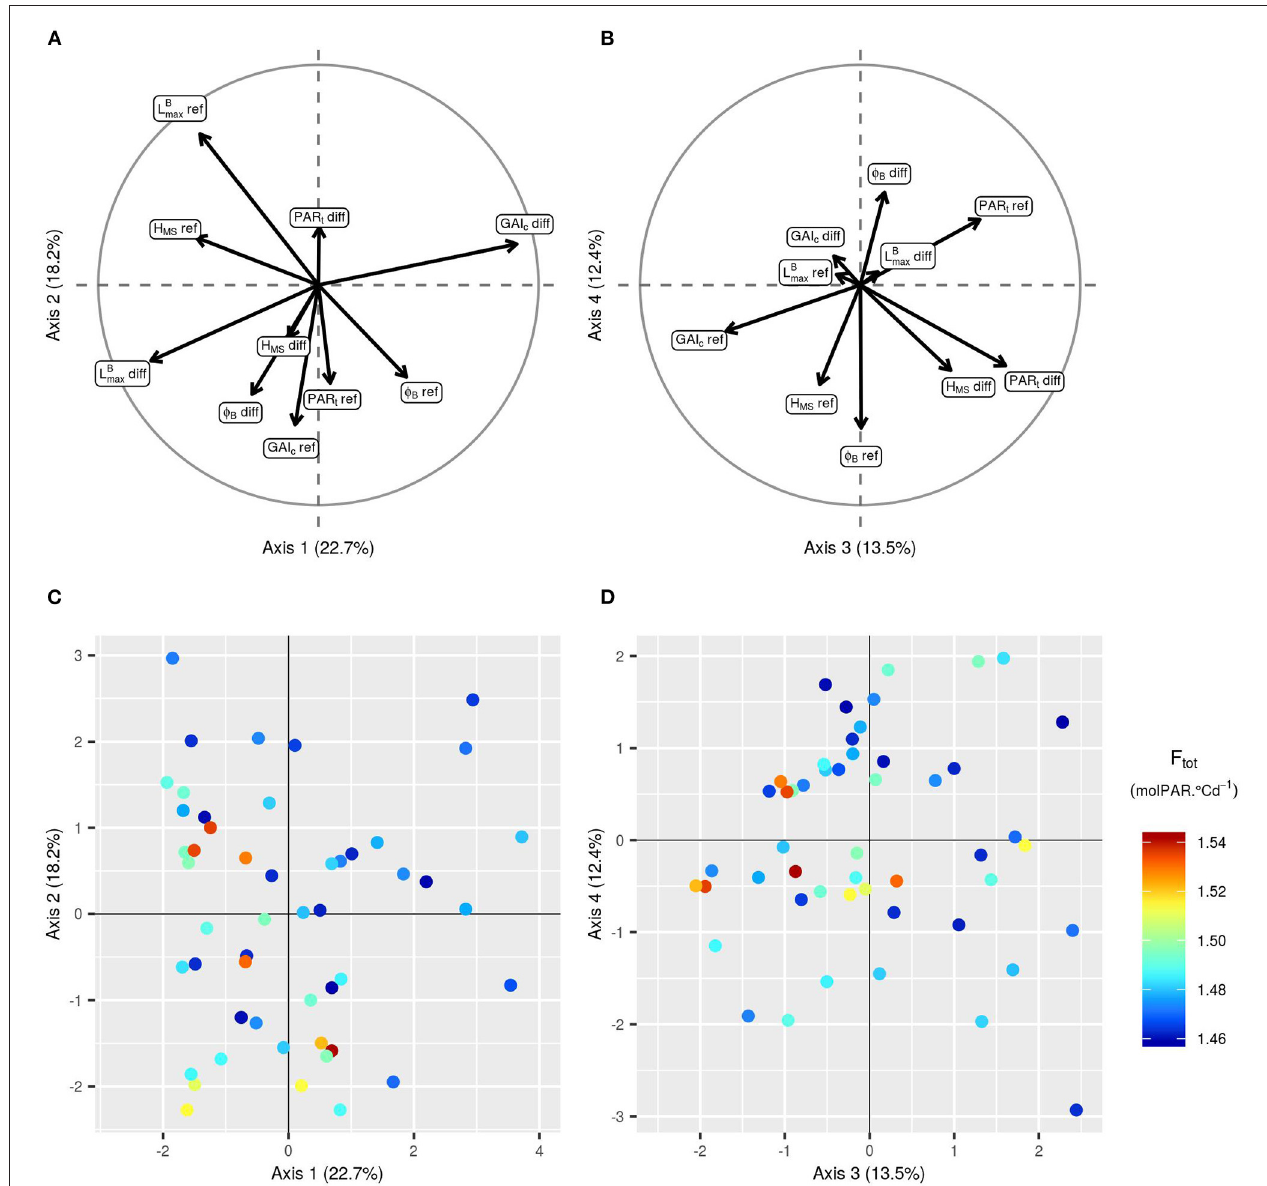
FIGURE 7 | Principal components analysis (PCA) of the 10 input parameters for the 50 simulations of the initial LHS with the highest F tot . Projection of the 10 input parameters on the first two axes (A) and on the third and fourth axes of the PCA (B) . Projection of the 50 points on the first two axes of the PCA (C) and on the third and fourth axes of the PCA (D) . The points are colored according to the corresponding value of F tot . To avoid redundancy in the combinations of parameters, results are represented only with positive values of L B max